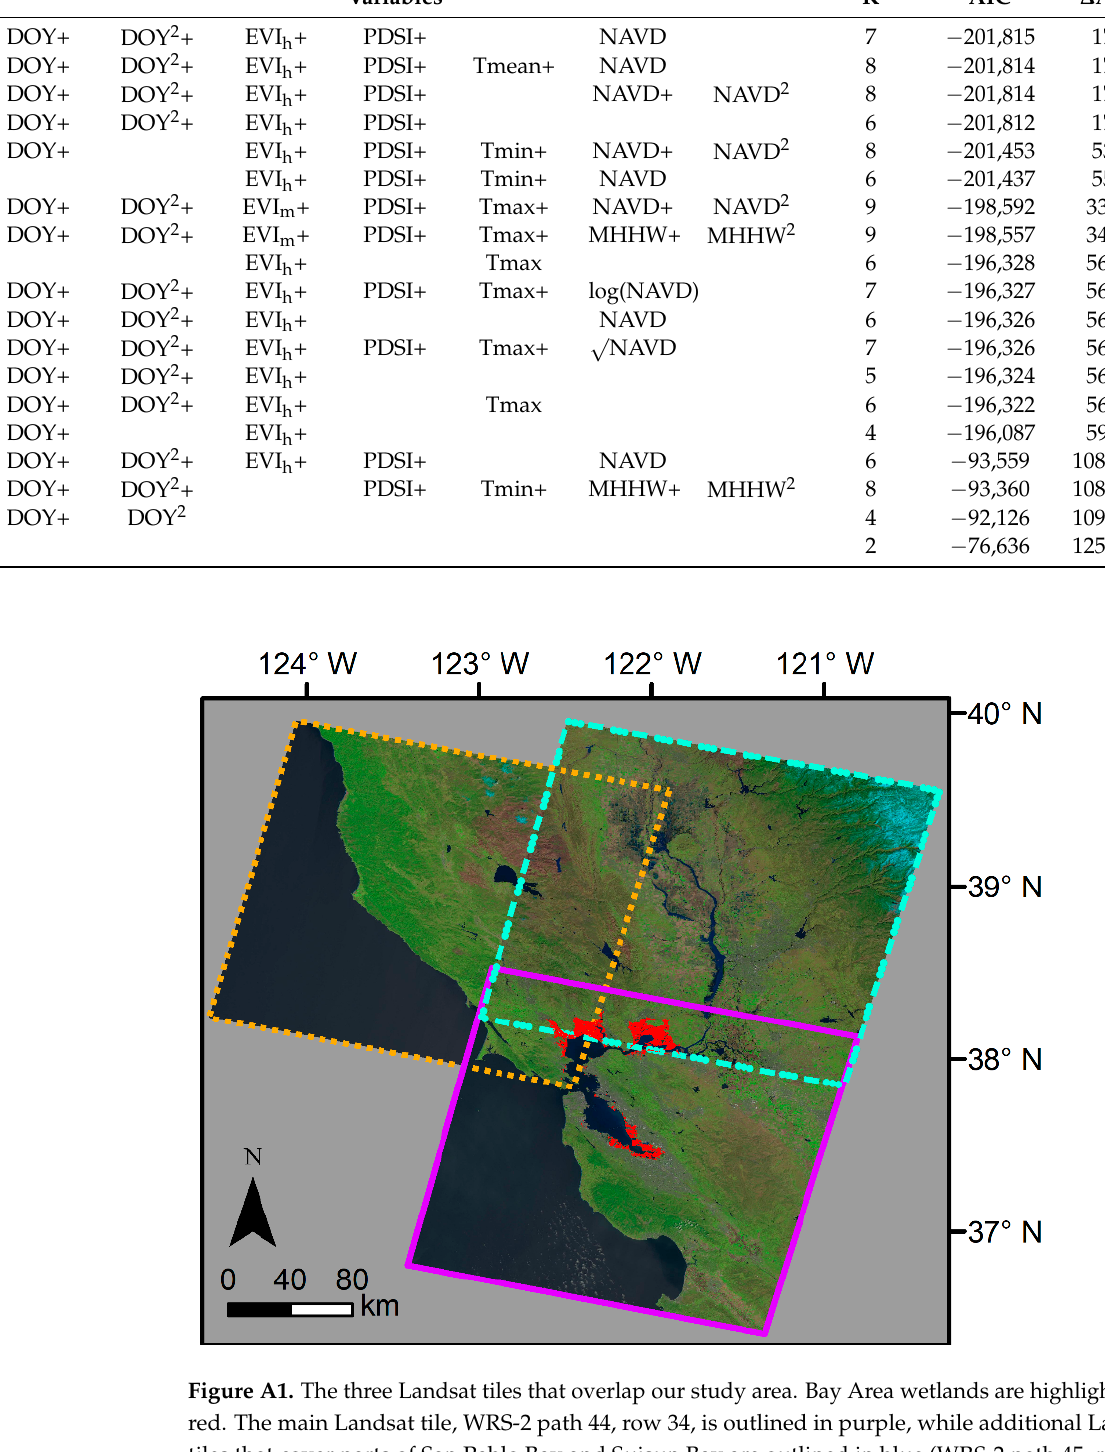
( A ) ( B ) Figure A2. Model error (mean difference) within restoration project sites. Mean difference refers to the Landsat observed minus 2019 predicted EVI. We used a restoration project database obtained from EcoAtlas to calculate the mean difference within each site. ( A ) The mean difference averaged within the restoration project site. ( B ) End date of the restoration project, as obtained from EcoAtlas. The dates are binned into categories for easier visualization. Basemap: Landsat 8 band 7 (SWIR 2), U.S. Geological Survey.